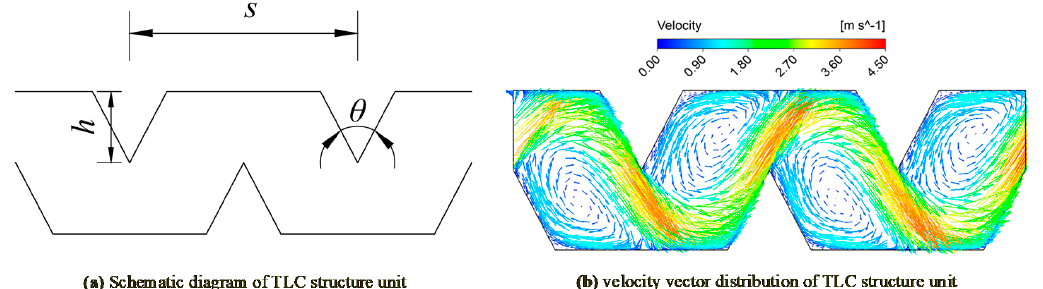
Figure 10. Schematic diagram and velocity vector distribution of the flow channel structures under 100 KPa.